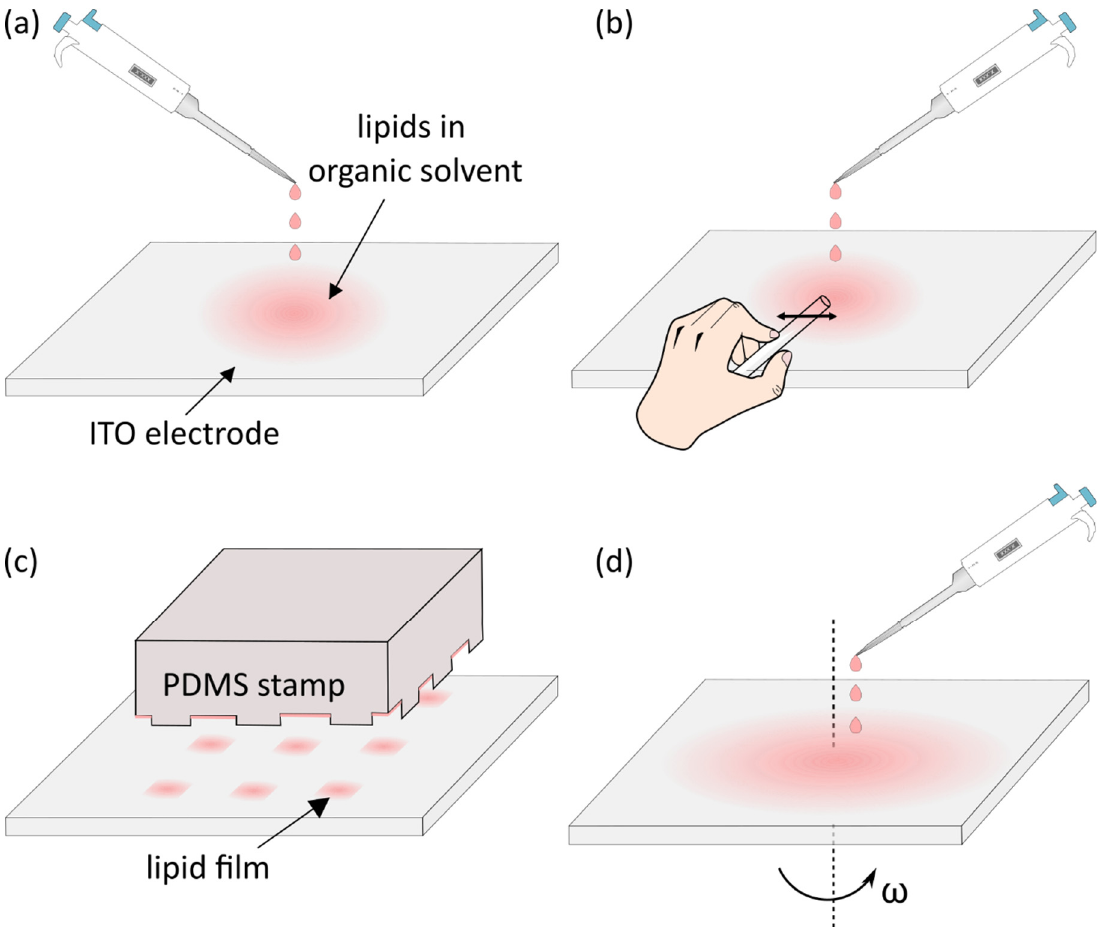
Figure 3. ( a ) Droplet deposition. ( b ) Droplet deposition with smearing afterward to better spread the lipid film. ( c ) Deposition of lipids by pressing a patterned silicon stamp on the electrode surface. ( d ) Spin-coating of lipid solution by fast rotation of the electrode immediately after the deposition.